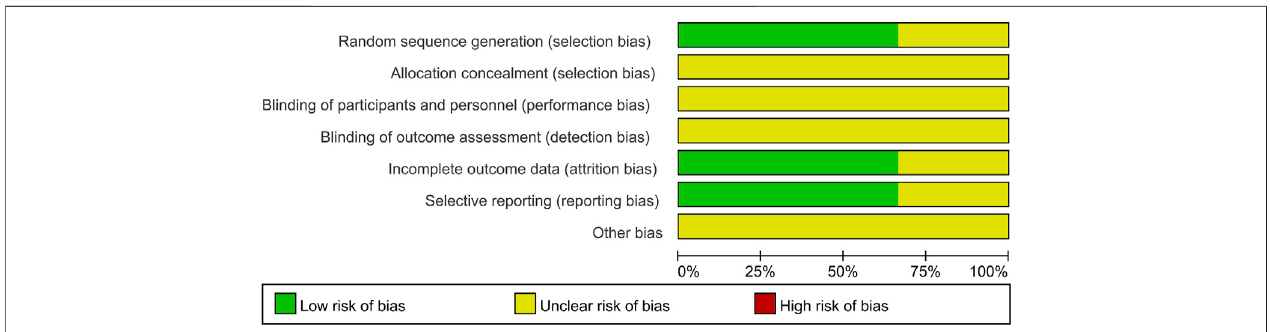
FIGURE2| Riskofbiasgraphpresented aspercentage acrossallstudies(green representslowriskofbias;red represents highriskofbias,and yellowrepresents an unclear risk of bias).